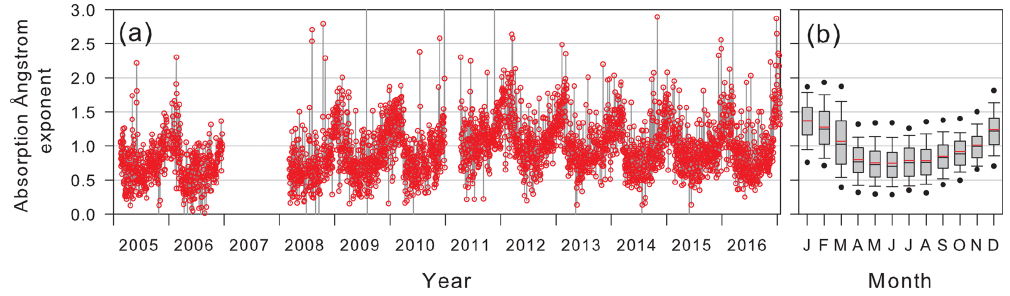
Figure 10. Seasonal features of (a) daily median AAE ( λ = 370–950nm) and (b) monthly box plot of AAE at Syowa since February 2005. AAE data were not available in January 2007–January 2008 and January 2011–early April 2011 because of mechanical troubles with the Aethalometer. In box plots, the upper bar, upper box line, black middle box line, bottom box line, and bottom bar respectively denote values of 90%, 75%, 50% (median), 25%, and 10%. The red line shows mean values.